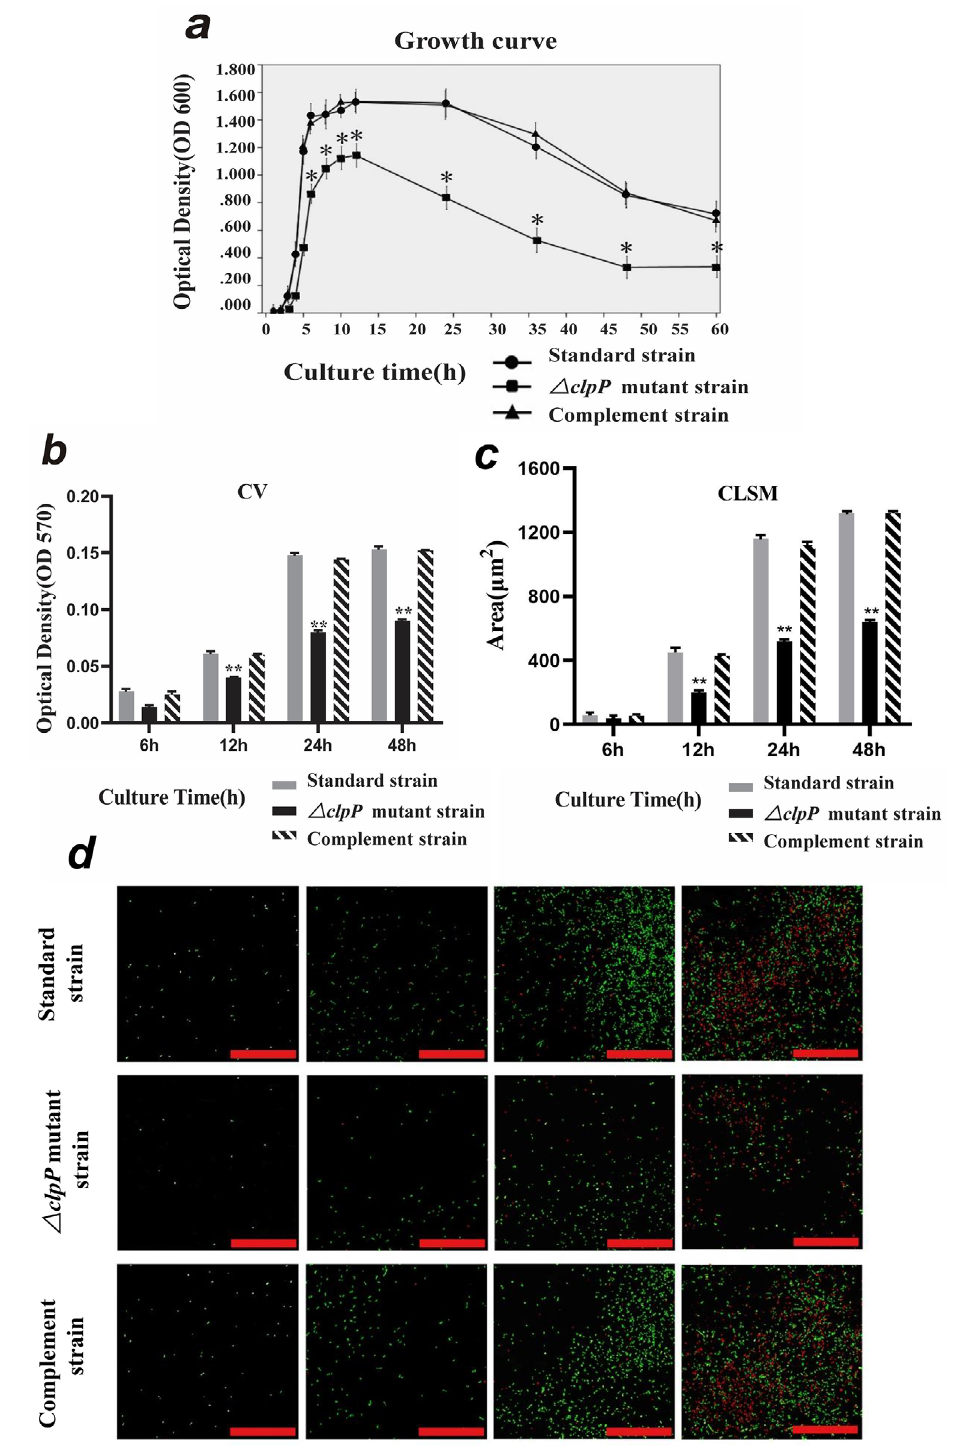
Figure 3- ClpP protease deletion inhibited growth and biofilm mass of E. faecalis. a) clpP gene deletion inhibits the growth of E. faecalis. The ∆clpP mutant strains exhibits impaired growth compared with the standard and clpP complement strains (p<0.05). b) Crystal violet staining shows that the biofilm mass in the ∆clpP mutant strains decreased at 12, 24, and 48 h (p<0.01) compared to the standard strains. c) CLSM examination of biofilm formation mass. The biofilm area in the ∆clpP mutant strains is smaller than that in the standard and complement strains at 12, 24, and 48 h (p<0.01). d) CLSM to observe the cell viability. The number of ∆clpP mutant bacteria increased slowly, and the proportion of dead bacteria (red) was greater than the standard and complement strains (green fluorescent signal: staining by SYT90; red fluorescent signal: staining by PI; scale bar = 50